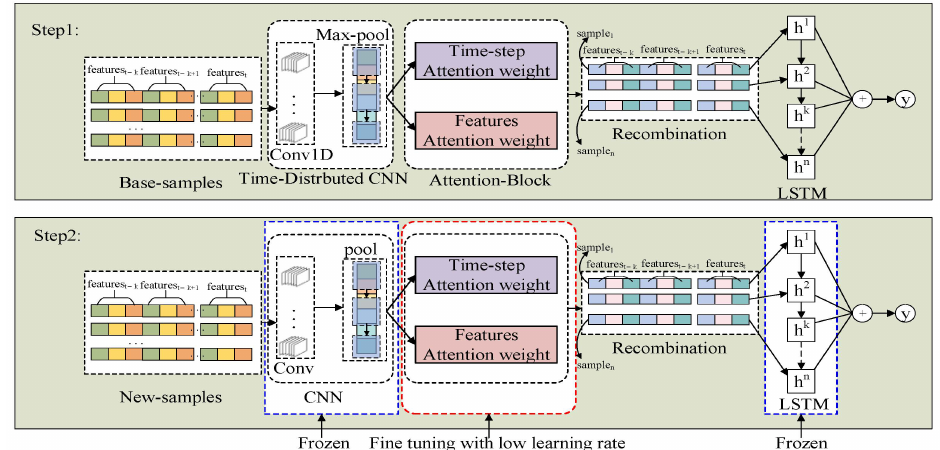
Figure 6. The training process of the TC-DLDPM